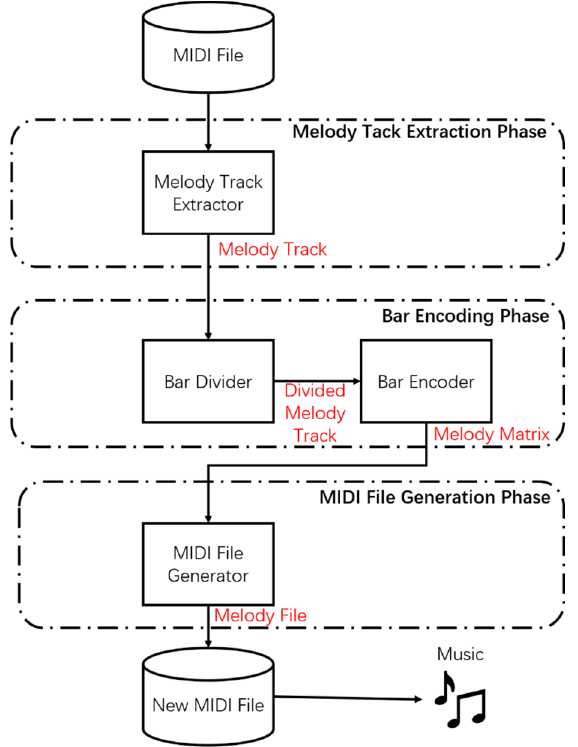
Figure 1. Proposed music generation system process.